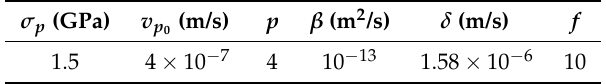
Optimized parameter values used for obtaining the best fit with the experimental load–displacement curve for single crystals of ( 110 ) orientation [12]. Other parameters are fixed at σ n = 7.0 GPa, σ m = 0.91 GPa and m = 11. Although the parameters σ p , v p and p have little influence on 0 the model F − z curves, the values cited are the values used for numerical fit with the